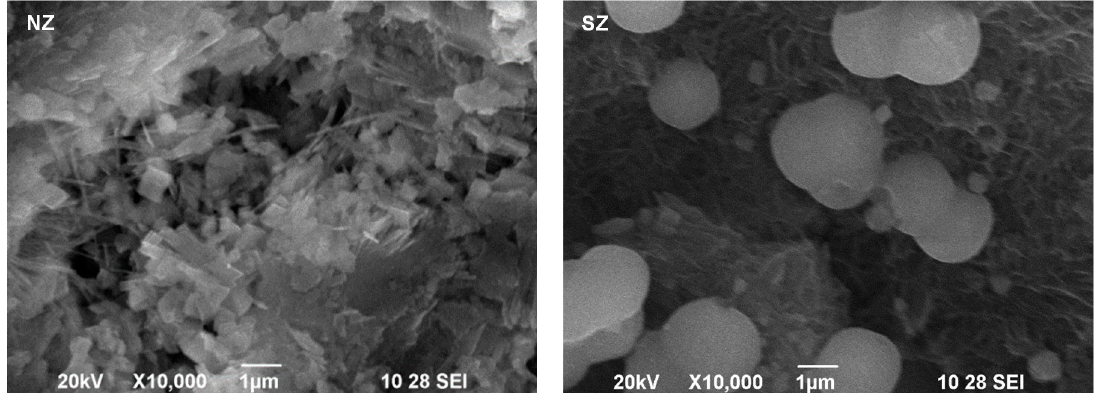
Figure 5. SEM secondary electron image of NZ ( left ) and SZ ( right ) at a magnification of 10,000×. The characteristic plate structure for clinoptilolite can be seen in the SEM images of NZ. At the same magnification, mostly regular spherical clusters were observed on the surface of SZ. An additional SEM image (Figure S1) of the SZ sample at a magnification of 600 × showed a clear change in surface morphology. Thus, the surface coverage is evident, which is the reason why clinoptilolite platelets are not visible in Figure 5 (right). This is also supported by a decrease in the SSA (Table 4).